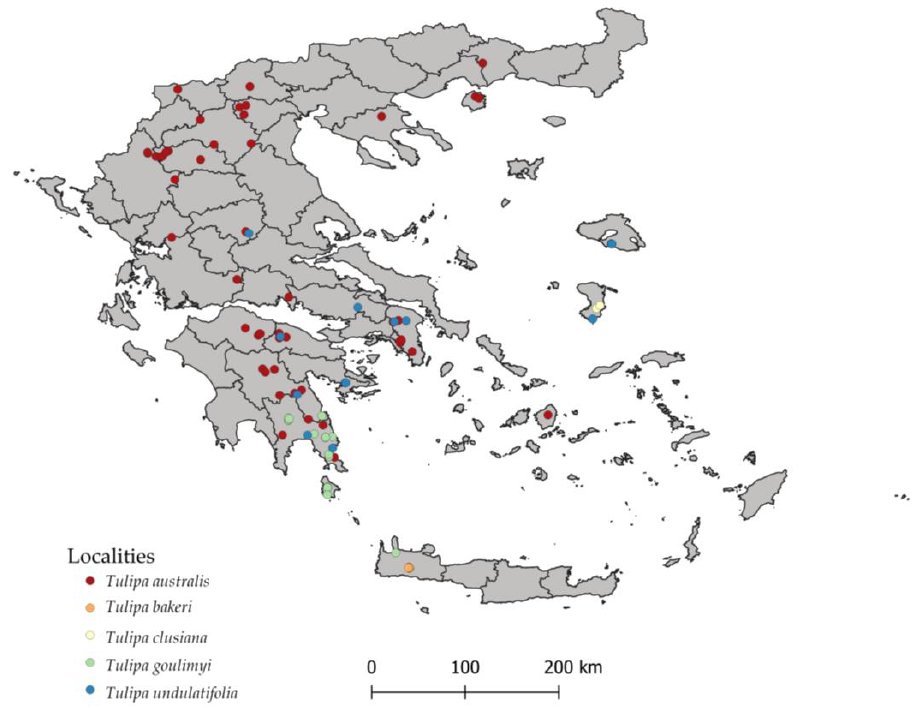
Figure 1. Overall known distribution of Tulipa australis, T. bakeri, T. clusiana, T. goulimyi , and T. un- dulatifolia in Greece. Red dots: distribution of T. australis (71 localities); orange dots: distribution of T. bakeri (11 localities); yellow dots: distribution of T. clusiana (2 localities); green dots: distribution of T. goulimyi (25 localities); blue dots: distribution of T. undulatifolia (24